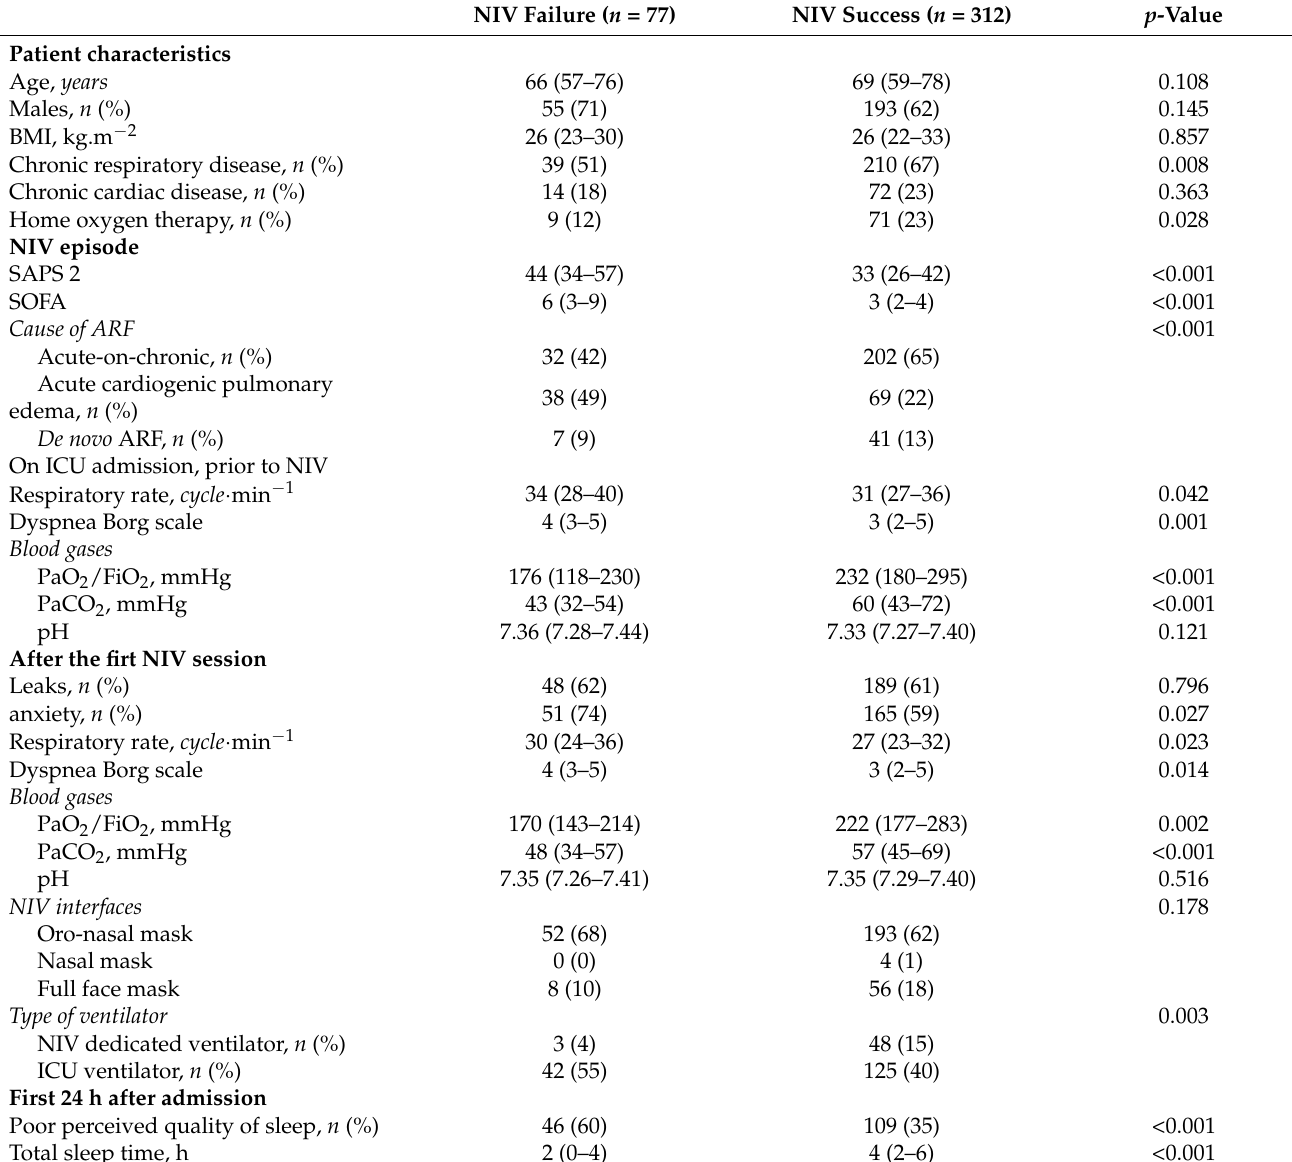
Table 3. Univariate analysis: factors associated with NIV